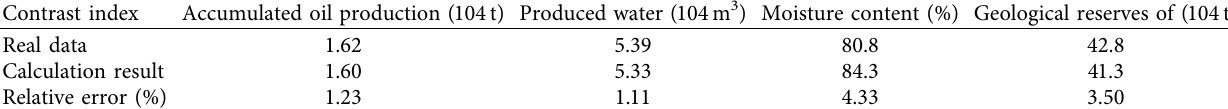
Table 3: Statistical table of development data